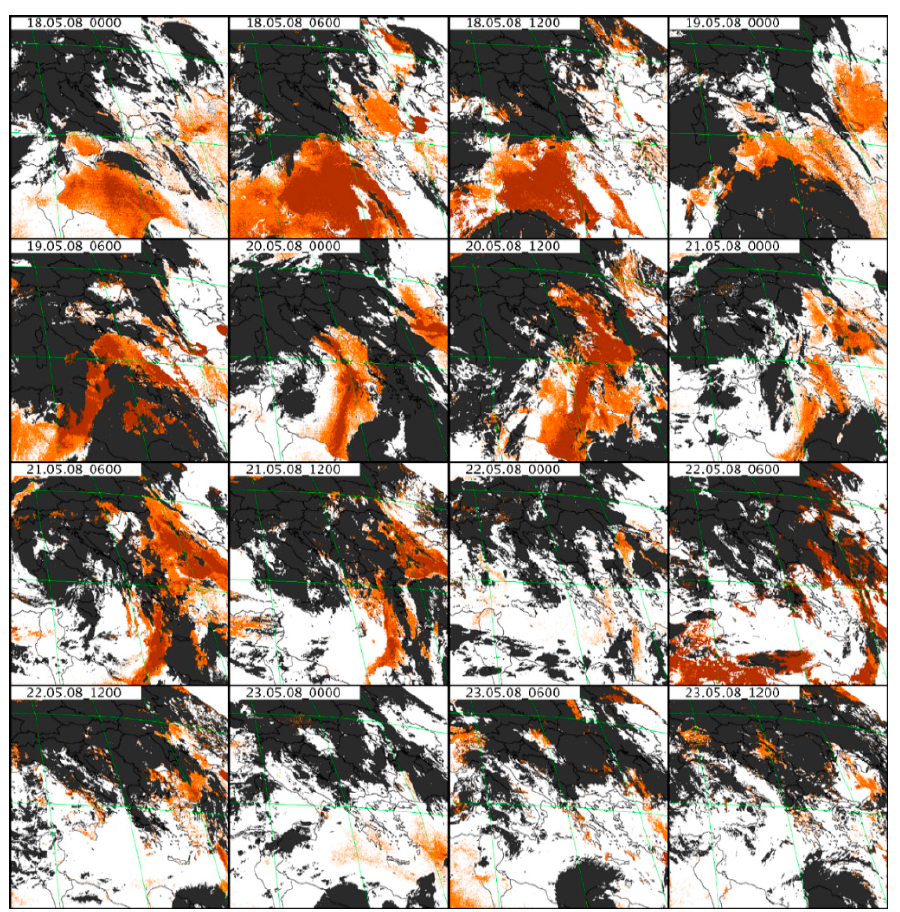
Figure 5. e RST DUST maps of 18–23 May 2008 generated the processed SEVIRI data of 00:00 UTC, 06:00 UTC, and 12:00 UTC. On daytime scenes, orange and brown pixels have the same meaning of Figure 2b. On night-time scenes, pixels with ⊗ TIR ( x,y,t ) > − 2 AND ⊗ Δ TIR ( x,y,t ) < − 2 are depicted in brown, while pixels with ⊗ TIR ( x,y,t ) > − 2 AND ⊗ Δ TIR ( x,y,t ) < − 1 are depicted in orange. In black, cloudy areas flagged by the EUMETSAT cloud mask product.